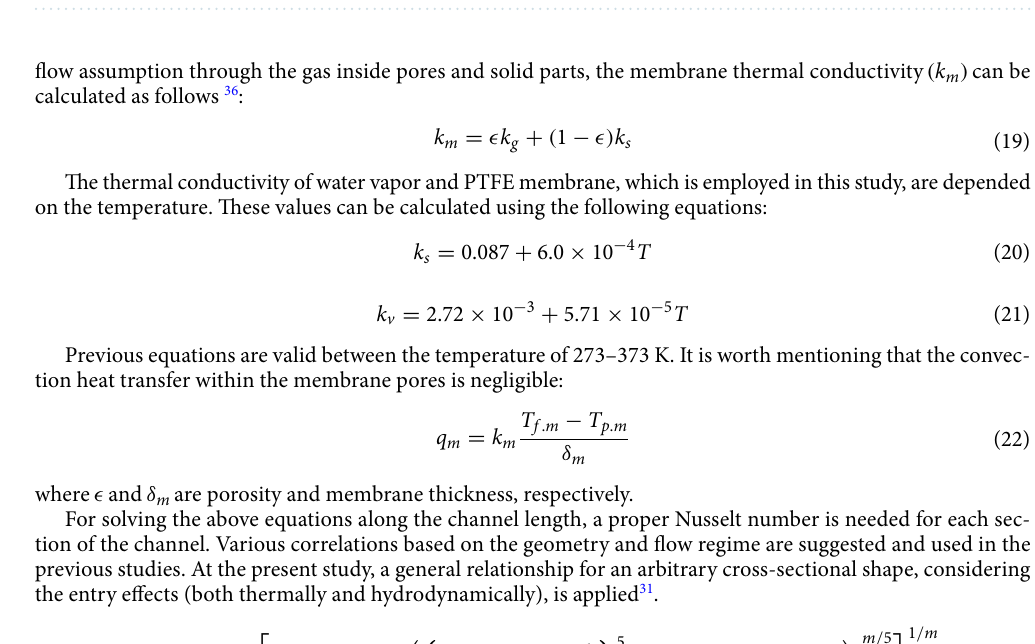
Pore size, r p Feed inlet temperature, T in . f Permeate inlet temperature, T in . p 25 °C Feed inlet volumetric flow rate, q in . f 10 l/min Permeate inlet volumetric flow rate, q in . f 10 l/min Feed Inlet salinity, s Table 1. Geometrical and operational parameters of DCMD module.